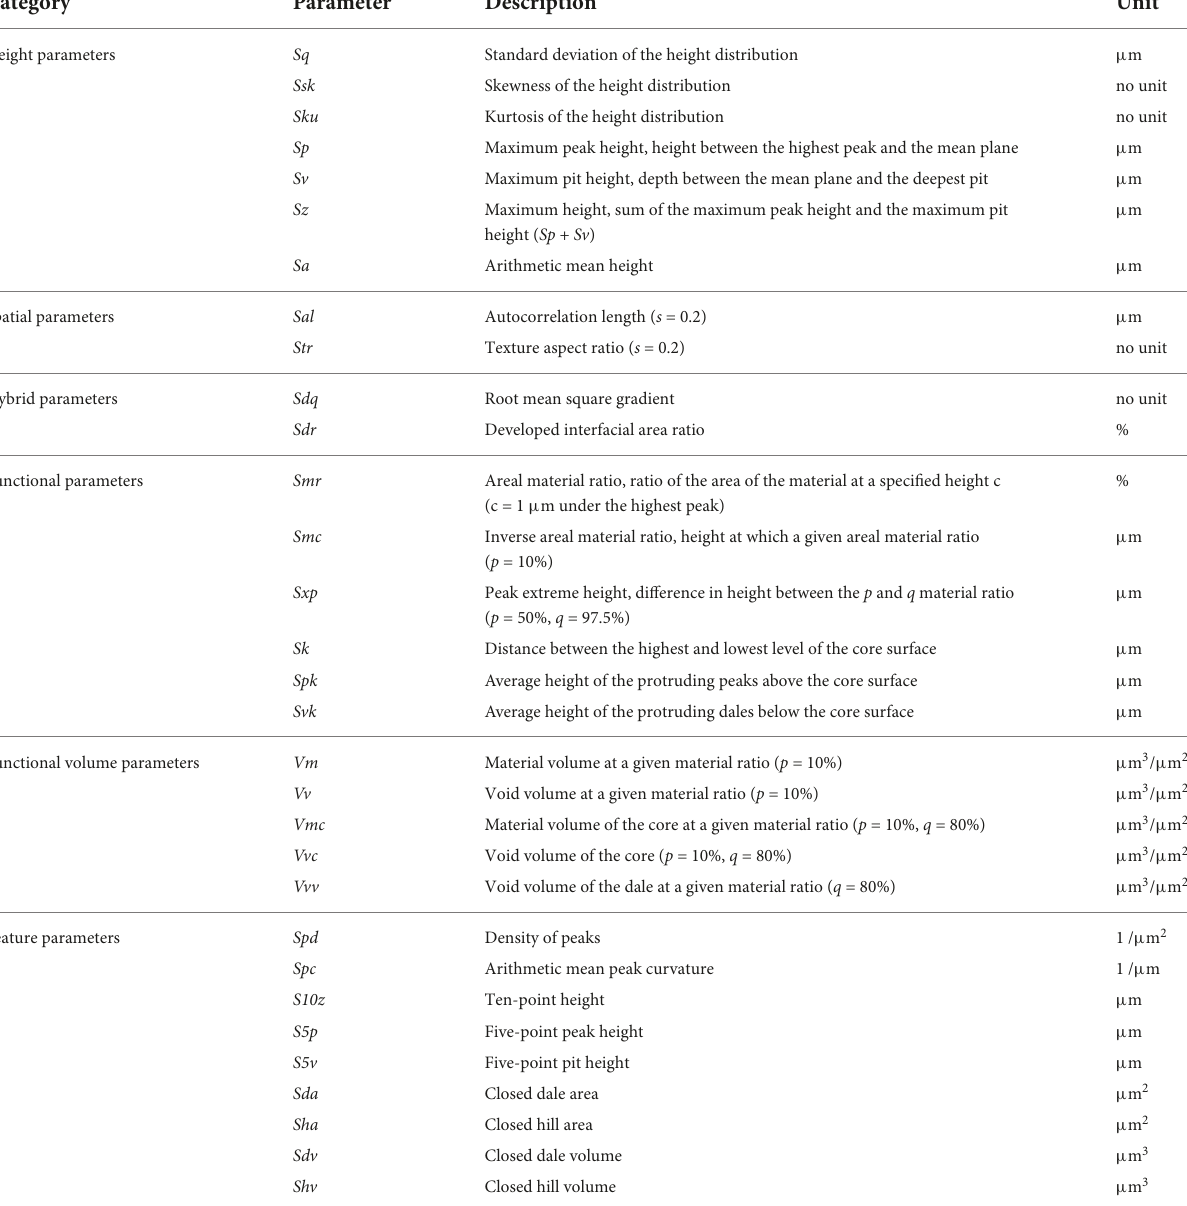
TABLE 2 Names and definitions of 31 DMT